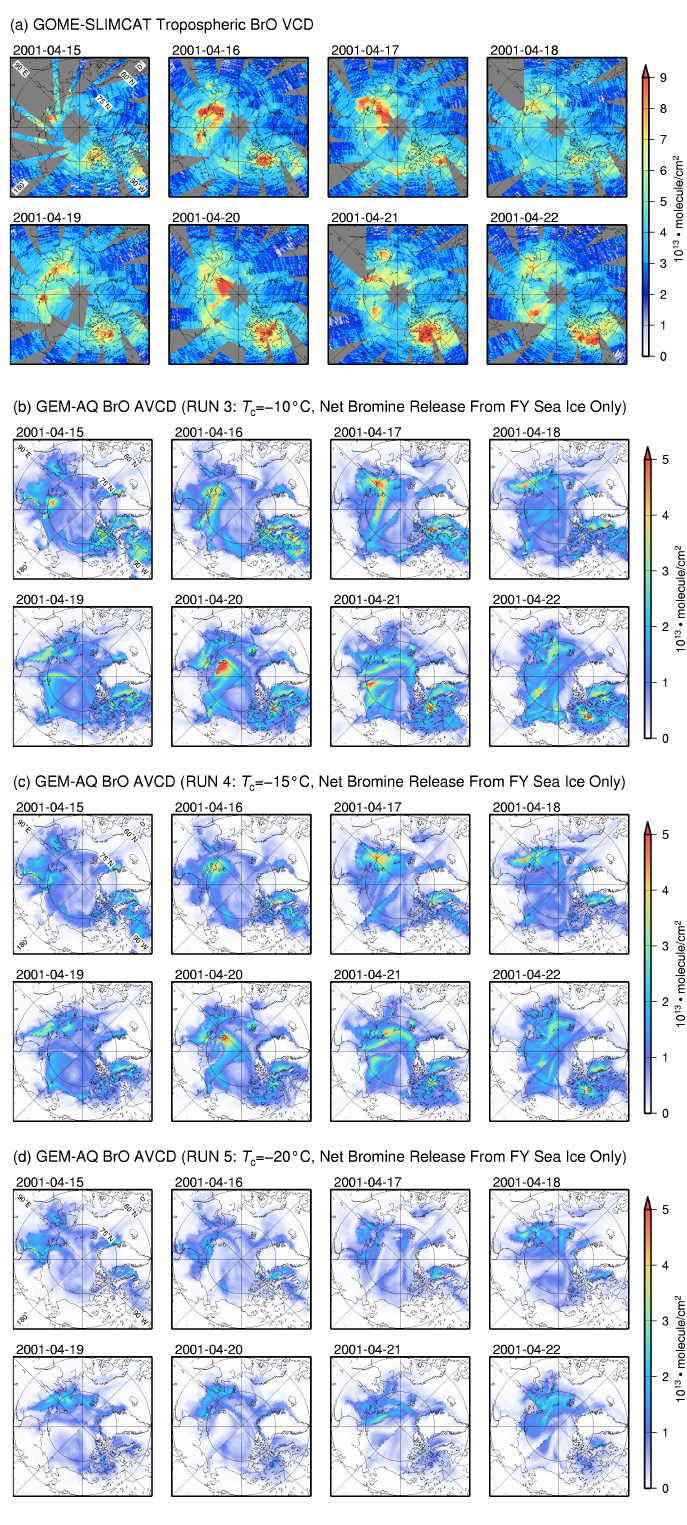
Fig. 8. (a) GOME-SLIMCAT tropospheric BrO VCDs (in moleculecm − 2 ) for each day between 15–22 April 2001; (b) The same as (a) but for BrO AVCDs (in moleculecm − 2 ) simulated by GEM-AQ in Run 3; (c) The same as (b) but simulated in Run 4; and (d) The same as (b) but simulated in Run 5. Note different color scales used for the GOME-SLIMCAT BrO VCDs and the GEM-AQ BrO AVCDs.